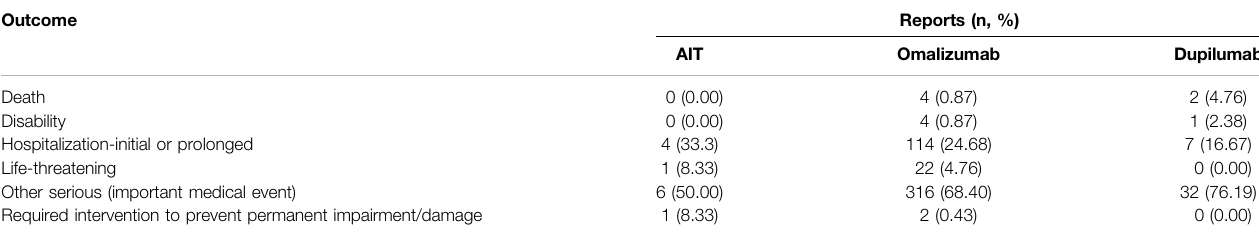
TABLE 6 | Clinical outcome of cases with AIT, omalizumab, and dupilumab related anaphylaxis in children. Outcome